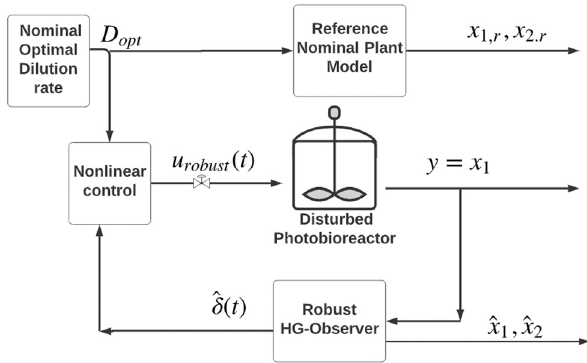
Figure 1: Diagram of the controller with the observer ( 13 ) . Usually, dynamic systems that model photobioreactors are disturbed by an unknown signal, ( ) δ t . Via nonlinear control ( 18 ) , the aim must be reached that